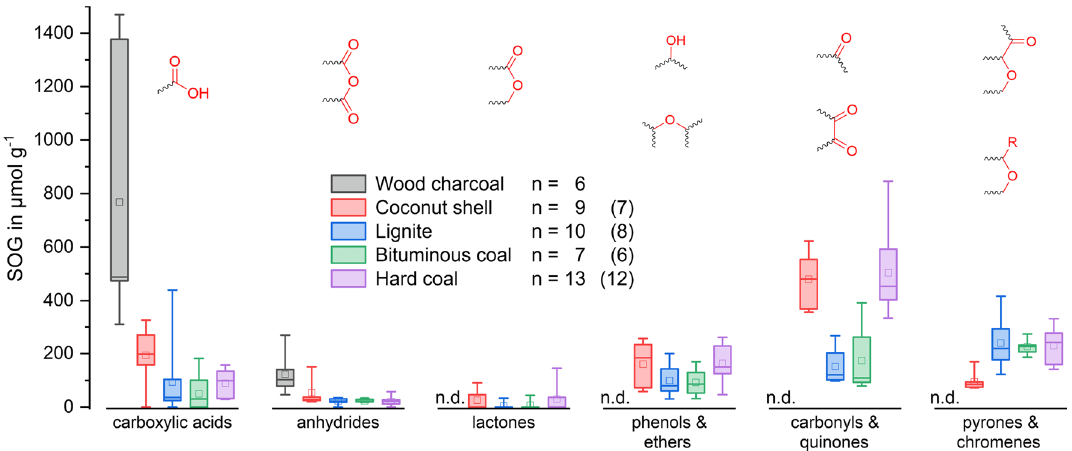
Fig. 8 Box plots grouped by SOGs and subgrouped by the raw mate- rial of ACs with whiskers representing the span; boxes include 50% of the results; means are given as squares and medians as horizontal